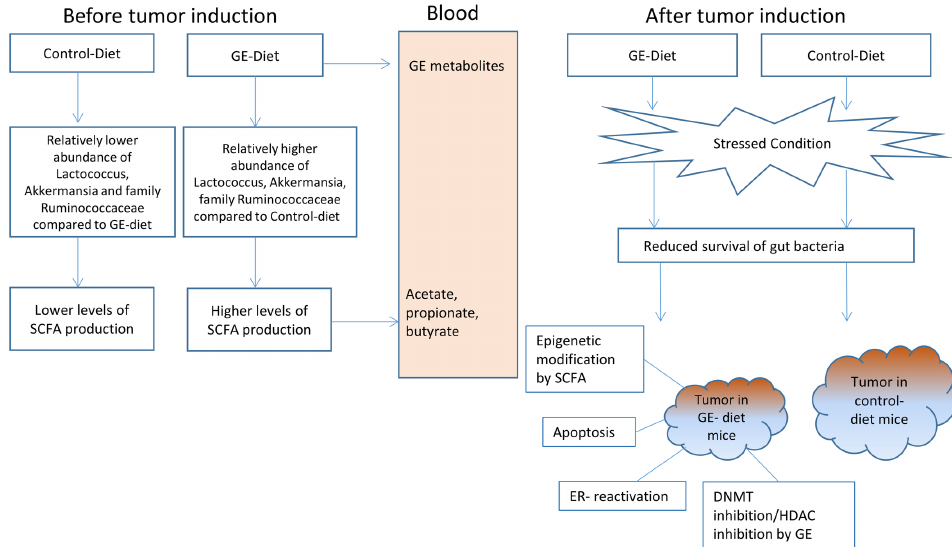
Fig 9. Hypothetical schematic for a mechanismof action of tumor reduction in GE-fed mice compared to control-fed mice. The figure shows a proposed mechanismfor the observedchanges in tumor reductionin GE-fed mice. The GE-fed mice had significantly different bacterial abundancesas comparedto control which may have caused an increasein SCFA synthesis. GE may have beenmetabolized by bacteria or otherwise into products that enhances the rate of apoptosisand delays the onset of tumor